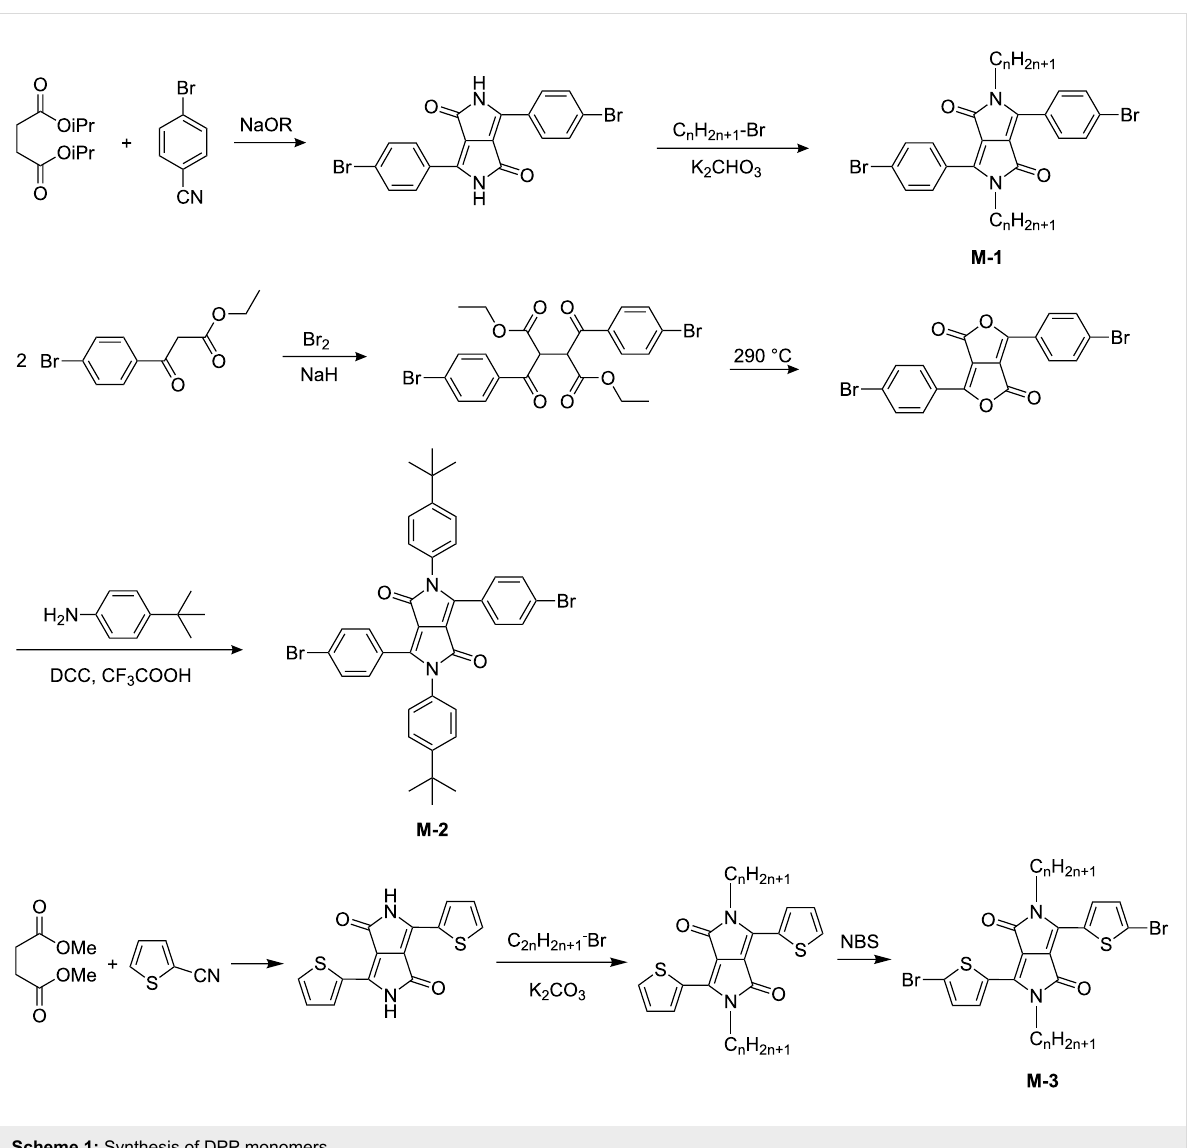
Scheme 1: Synthesis of DPP monomers.